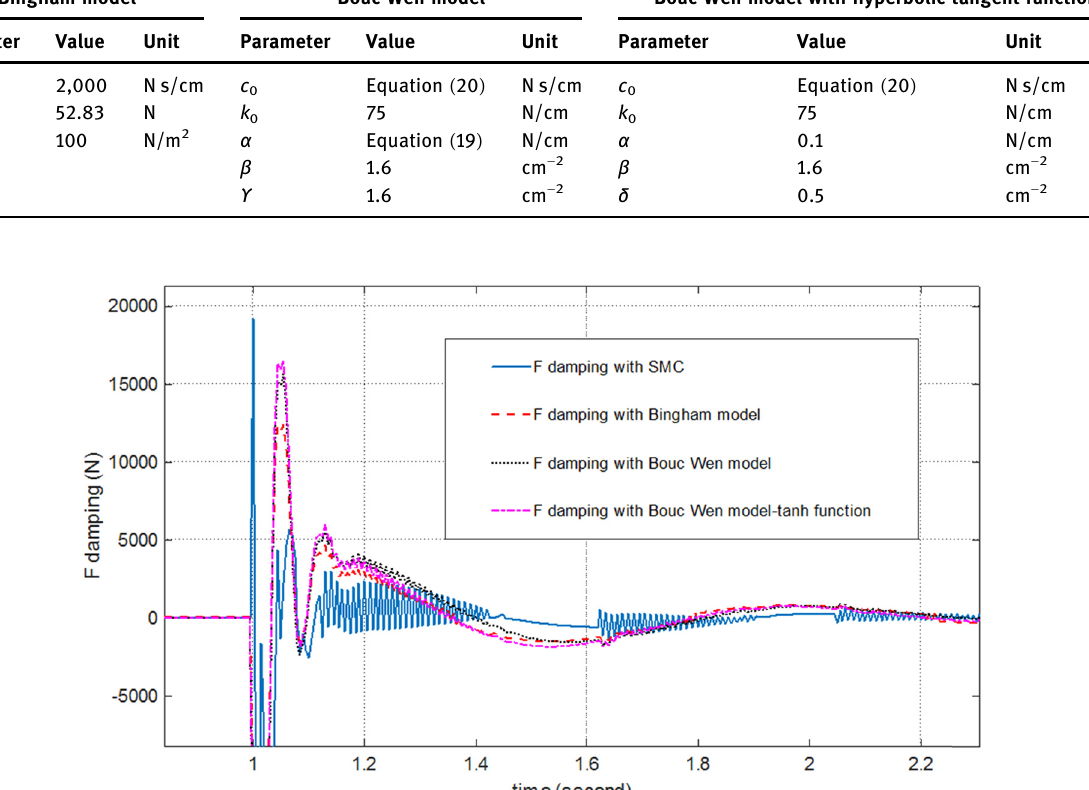
Table 3: MR damper model parameter Bingham model